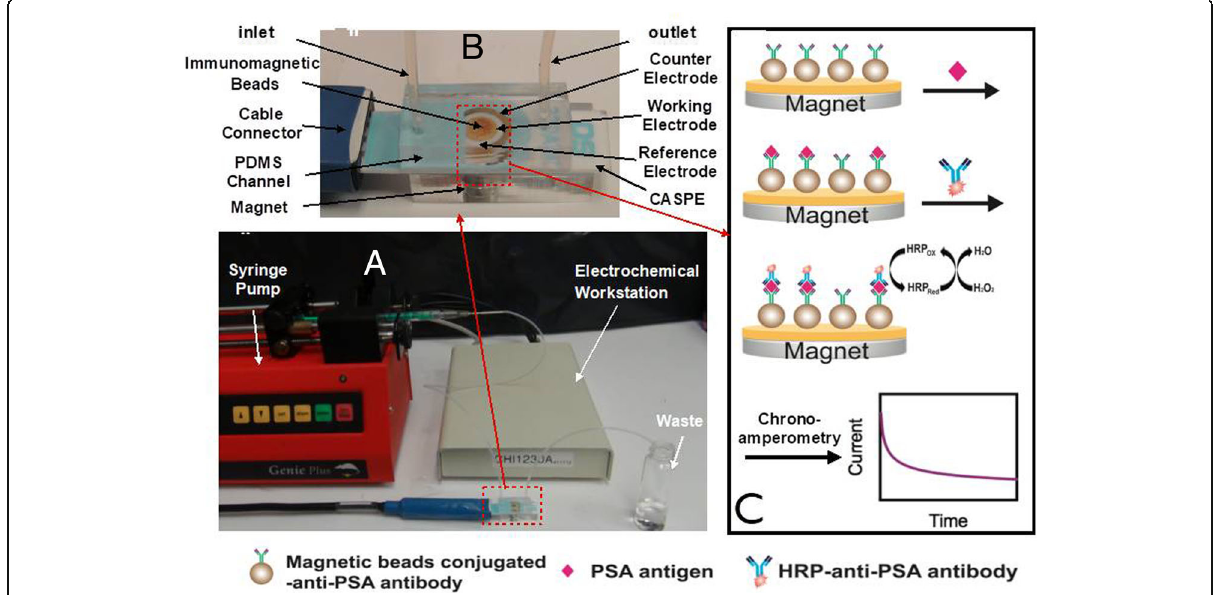
Fig. 4 a The whole detection device. The syringe pump was used to inject solution into the CASPE-MFD, and the electrochemical workstation was used to detect the electrochemical signals. b The CASPE-MFD used to detect PSA. Immunomagnetic bead-conjugated anti-PSA antibody was injected with solutions through inlet, and a magnet was used to capture the magnetic beads. c Schematic of the CASPE-MFD in detection of PSA antigen. Immunomagnetic bead-conjugated anti-PSA antibody was immobilized on the working electrode using a magnet. PSA antigen was injected into the CASPE-MFD and conjugated with the anti-PSA antibody. HRP-modified anti-PSA antibody was then conjugated with PSA antigen. Chronoamperometry was used to detect the electrochemical signals that hydroquinone and hydrogen peroxide